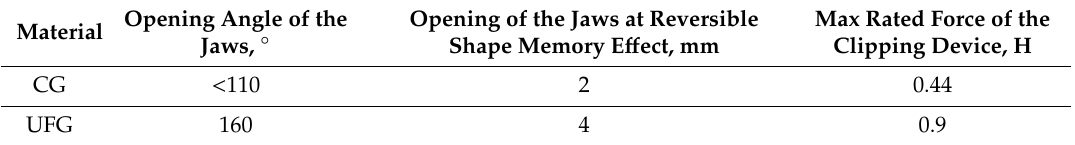
Table 2. Service characteristics of the clipping device produced from the NITi alloys. Opening Angle of the Material Jaws,